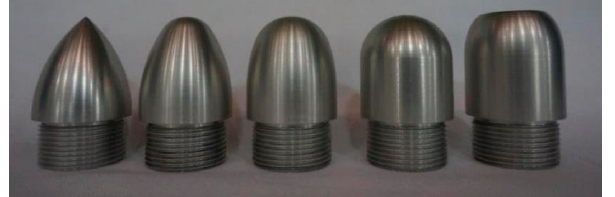
Figure 3. Five head shapes. The hemispherical angles from left to right are 0°, 57°, 70°, 90°, 180°. Table 1. Model parameters.